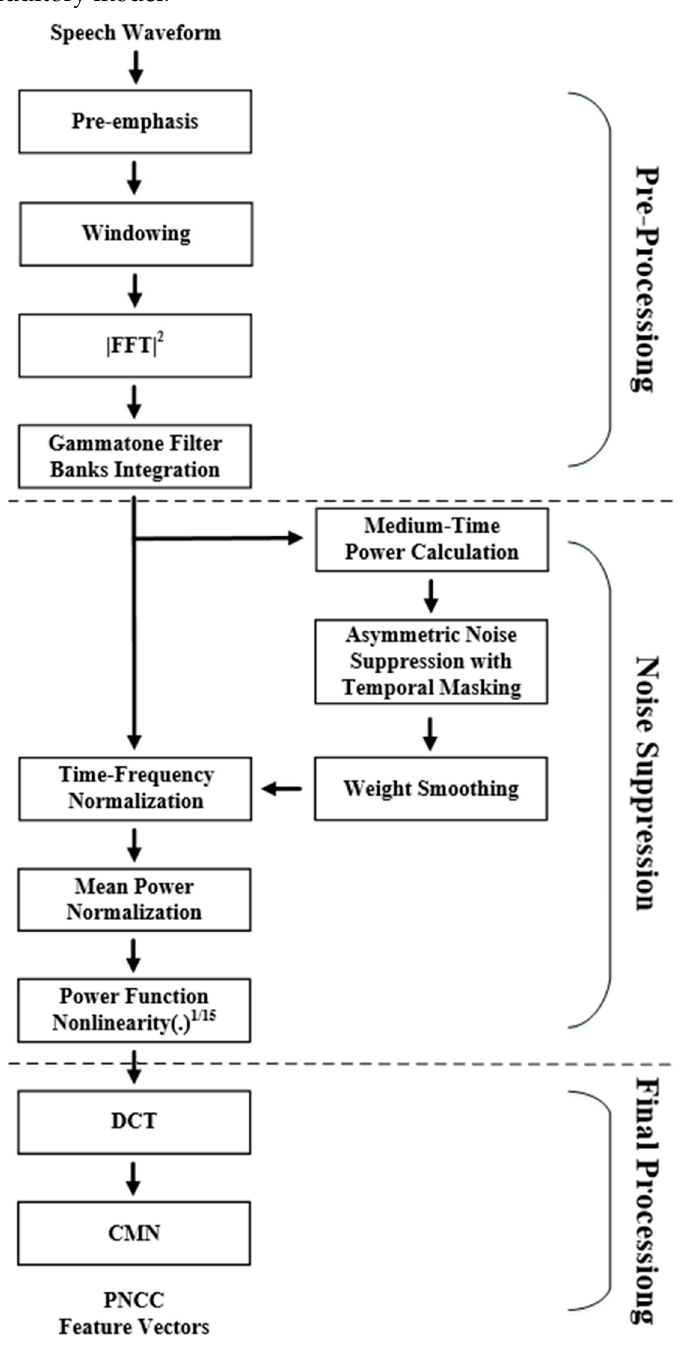
Figure 8. Flow chart of PNCC.